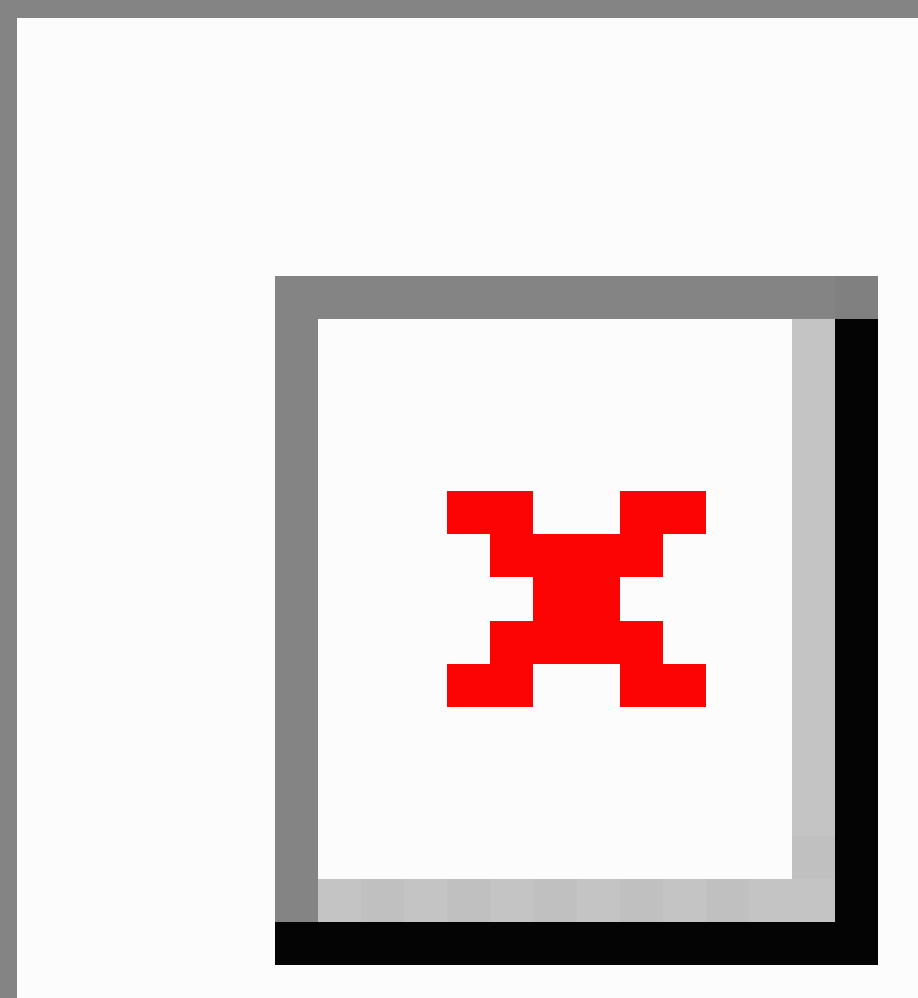
Figure 1. Time between self-reported and clinic weights at 6 and 24